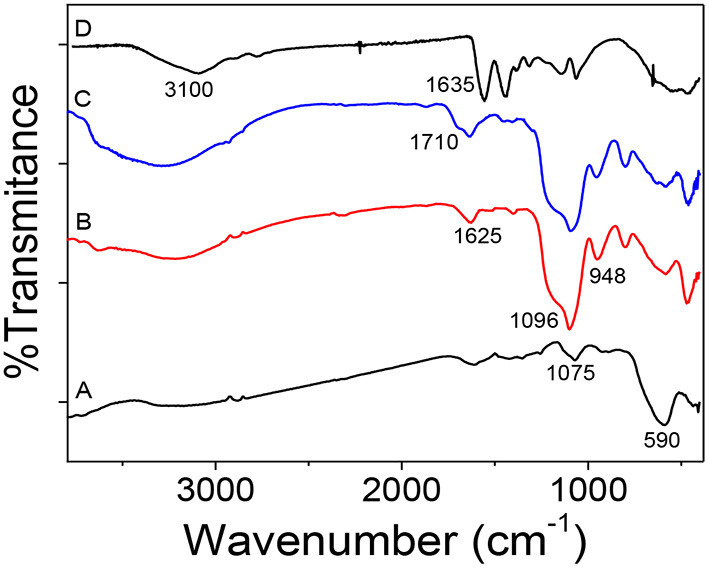
FTIR spectra: (A) Fe3O4, (B) Fe3O4@SiO2, (C) Fe3O4@MPS, and (D) mag-MIP.